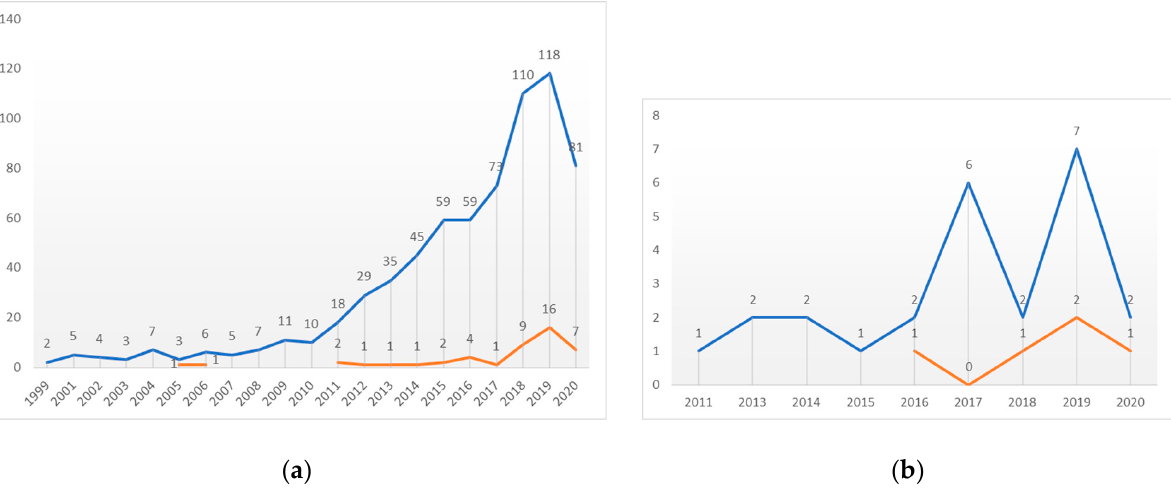
Figure 2. Life cycle of the publications relating “augmented reality” with ( a ) “cultural heritage” (in blue) and “dissemination” (in orange); ( b ) “architectural heritage” (in blue) and “dissemination” (in orange).